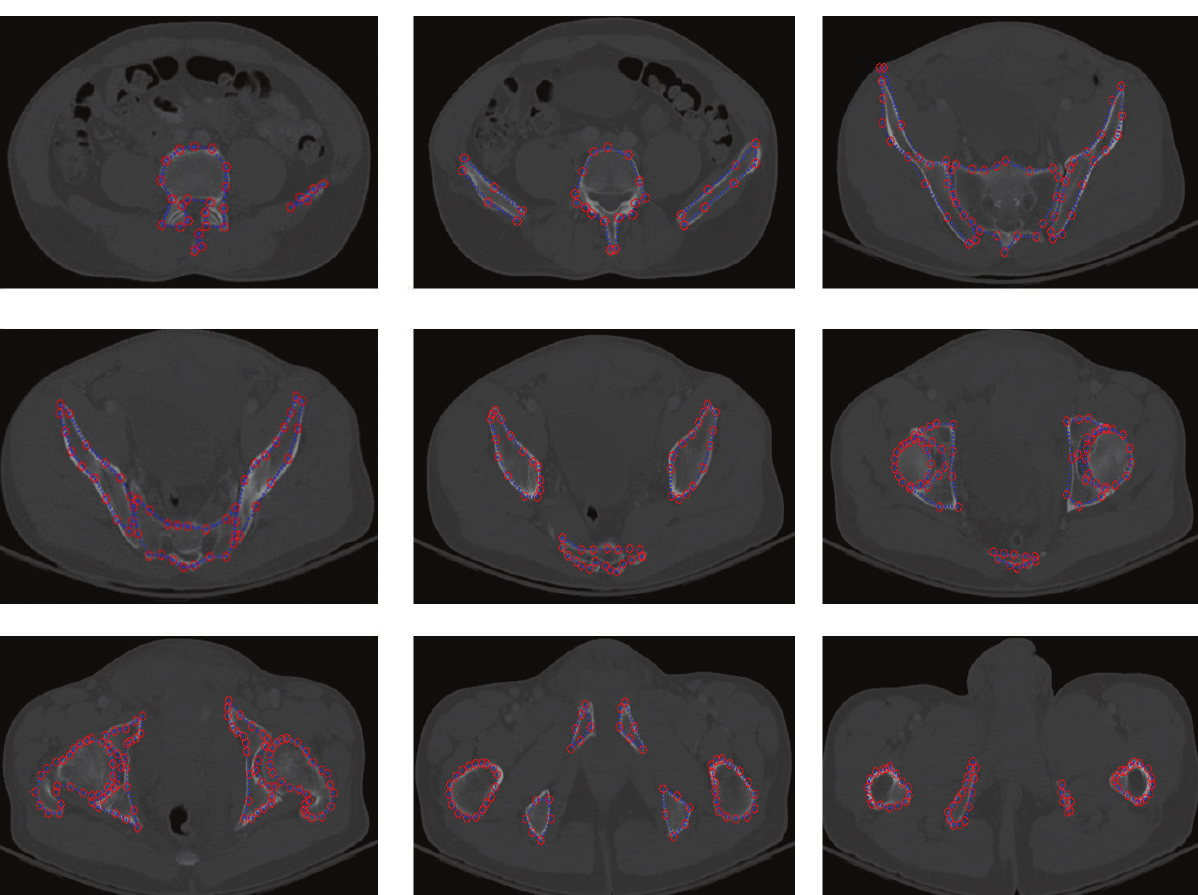
Figure 6: Example of pelvic bone segmentation results via